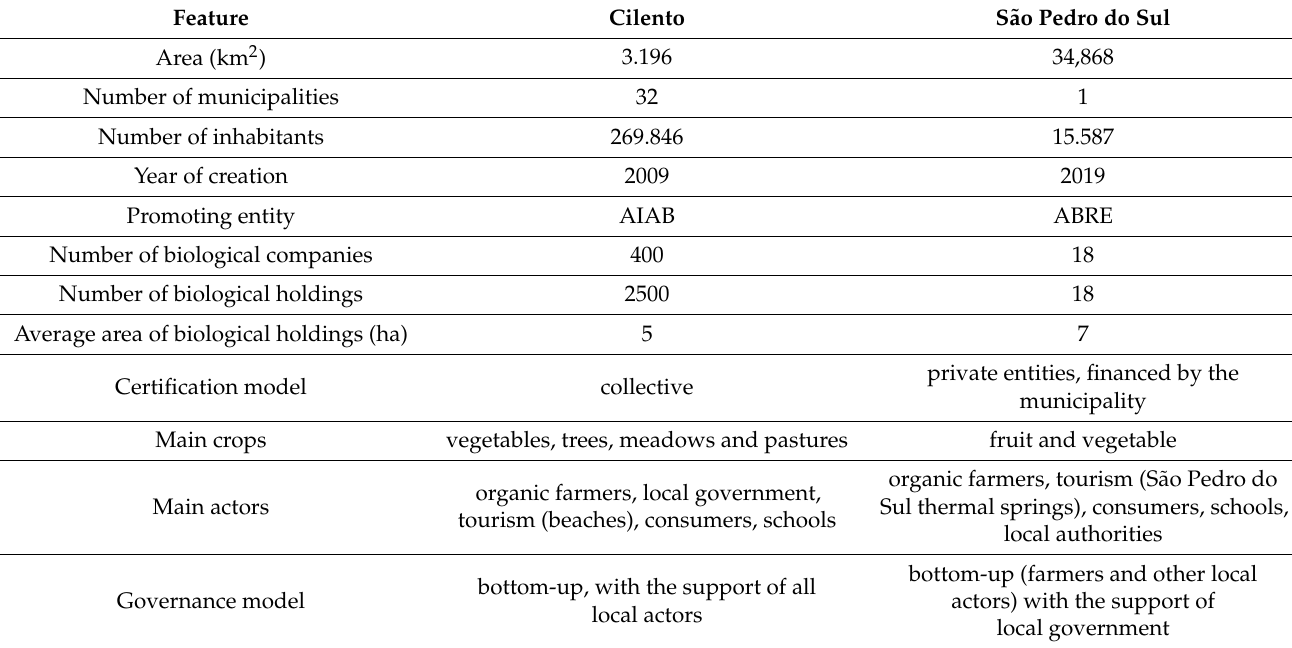
Table 1. Comparison of some characteristics of the Cilento and S ã o Pedro do